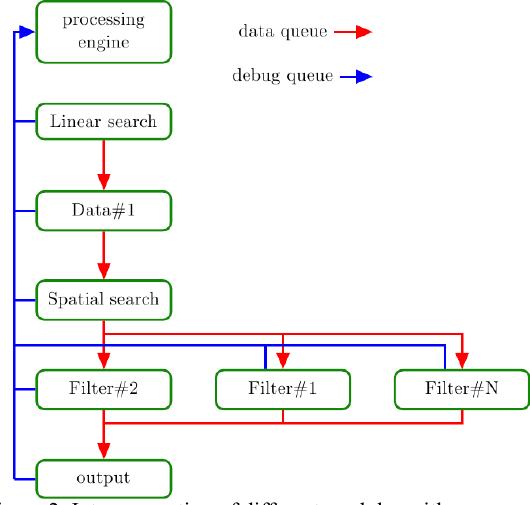
Figure 2: Interconnection of different modules with queues